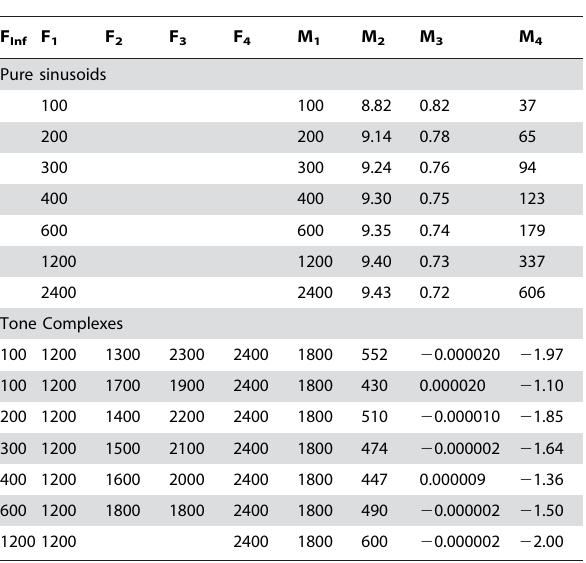
Table 1. Spectral values of the auditory